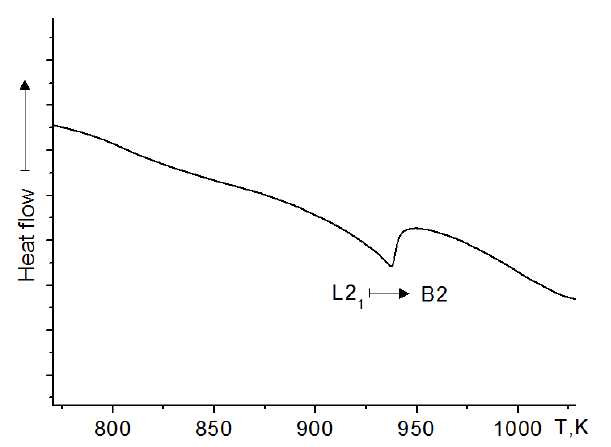
Figure 4. DSC peak associated with the L2 1 -B2 order–disorder transition.